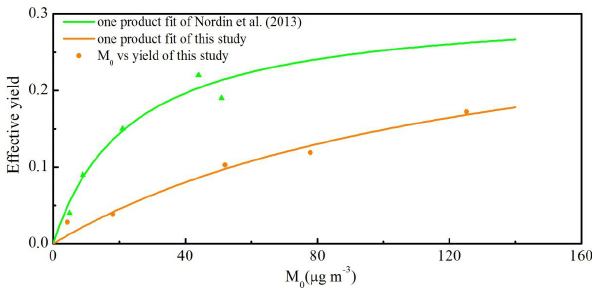
Figure 4. Comparison of yield data obtained for the gasoline ex- periments in this study with that of Nordin et al. (2013). The green line is the best fit one-product model ( α 1 = 0.311, K om , 1 = 0.043) for the data set of Nordin et al. (2013). The orange line is the best one-product fit to the effective SOA yield in this study ( α 1 = 0.350, K om , 1 = 0.007). Organic precursors in the calculation of effective yields included benzene, toluene, C 2 -benzene, C 3 -benzene, C 4 - benzene and